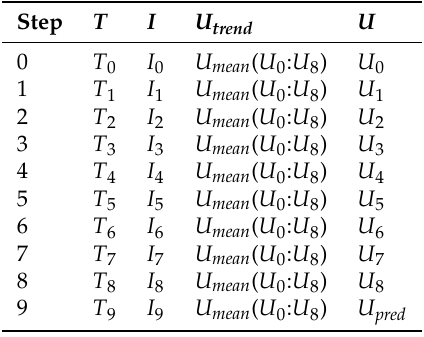
Table 2. Prediction scheme with sequence length of